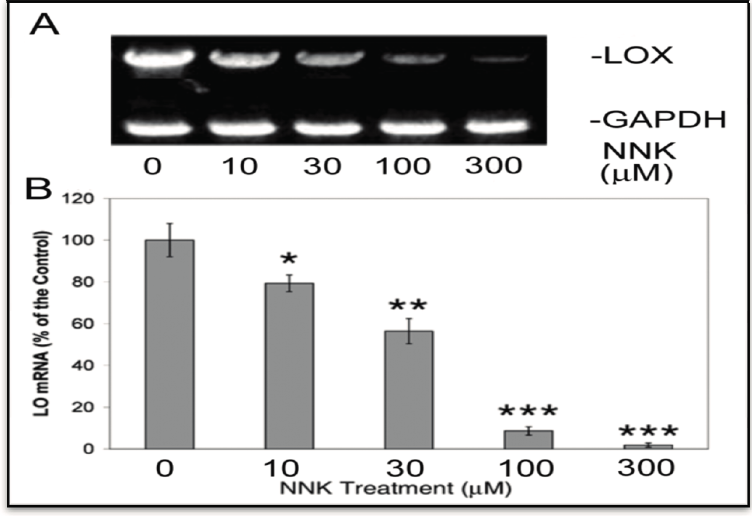
Figure 3. NNK inhibition of LOX steady–state mRNA levels in treated cells as revealed by reverse transcription (RT)-PCR and agarose gel electrophoresis ( A ) and quantitative real-time-PCR ( B ). ( A ) Total RNA (1 µg) was extracted from growth-arrested control and treated cells using Trizol reagent. Reverse-transcription cDNA was produced using the SuperScript first-strand synthesis system. LOX and GAPDH (an internal control) cDNA fragments were amplified by PCR and analyzed on a 2.2% agarose gel. Densities of PCR-amplified gene fragments on the gel as described here and below were measured with the 1D Scan software. ( B ) The real-time PCR was performed by the GeneAmpR 5700 Sequence Detection System (SDS) using reverse-transcription DNA as a template. PCR products were monitored by fluorescence from the TaqMan probes for LOX and GAPDH (an internal control) and analyzed using the GeneAmp 5700 SDS software. Data shown are the mean ± SD ( n = 3). * p ≤ 0.05, ** p ≤ 0.01, *** p ≤ 0.001 compared with the